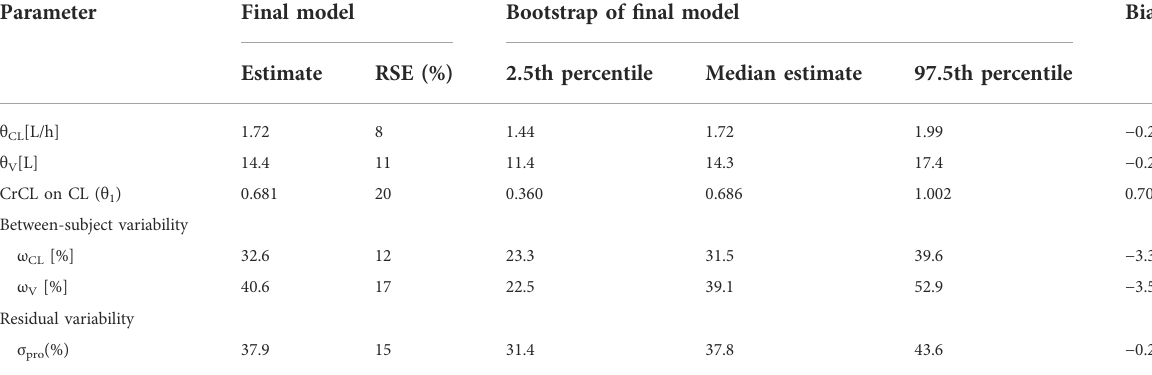
TABLE 3 Population pharmacokinetic parameter estimates from the fi nal model and bootstrap results.